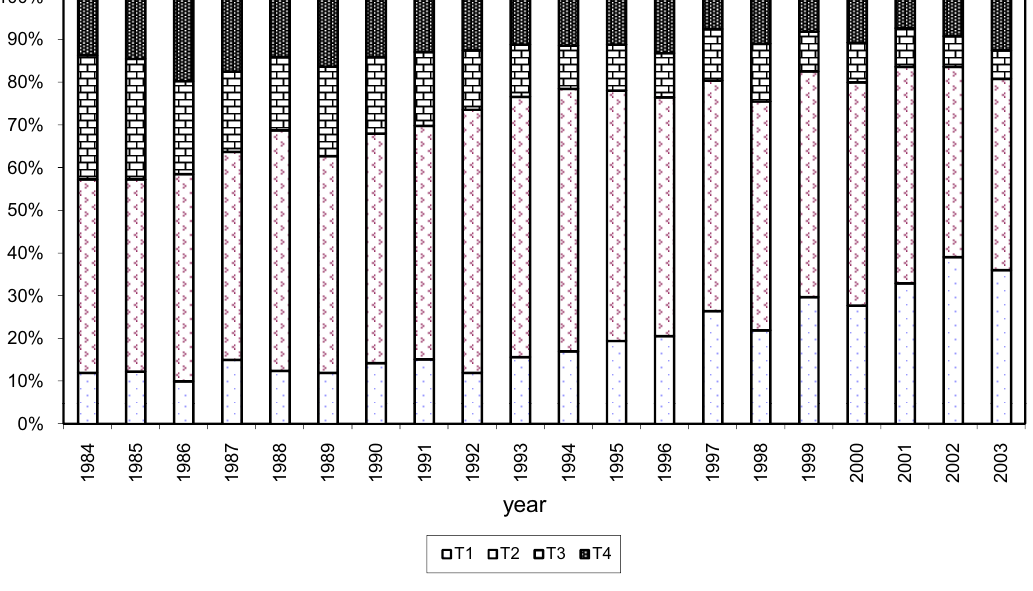
Fig. 4 Percentage of breast cancers diagnosed annually with different diameters according to TNM classification